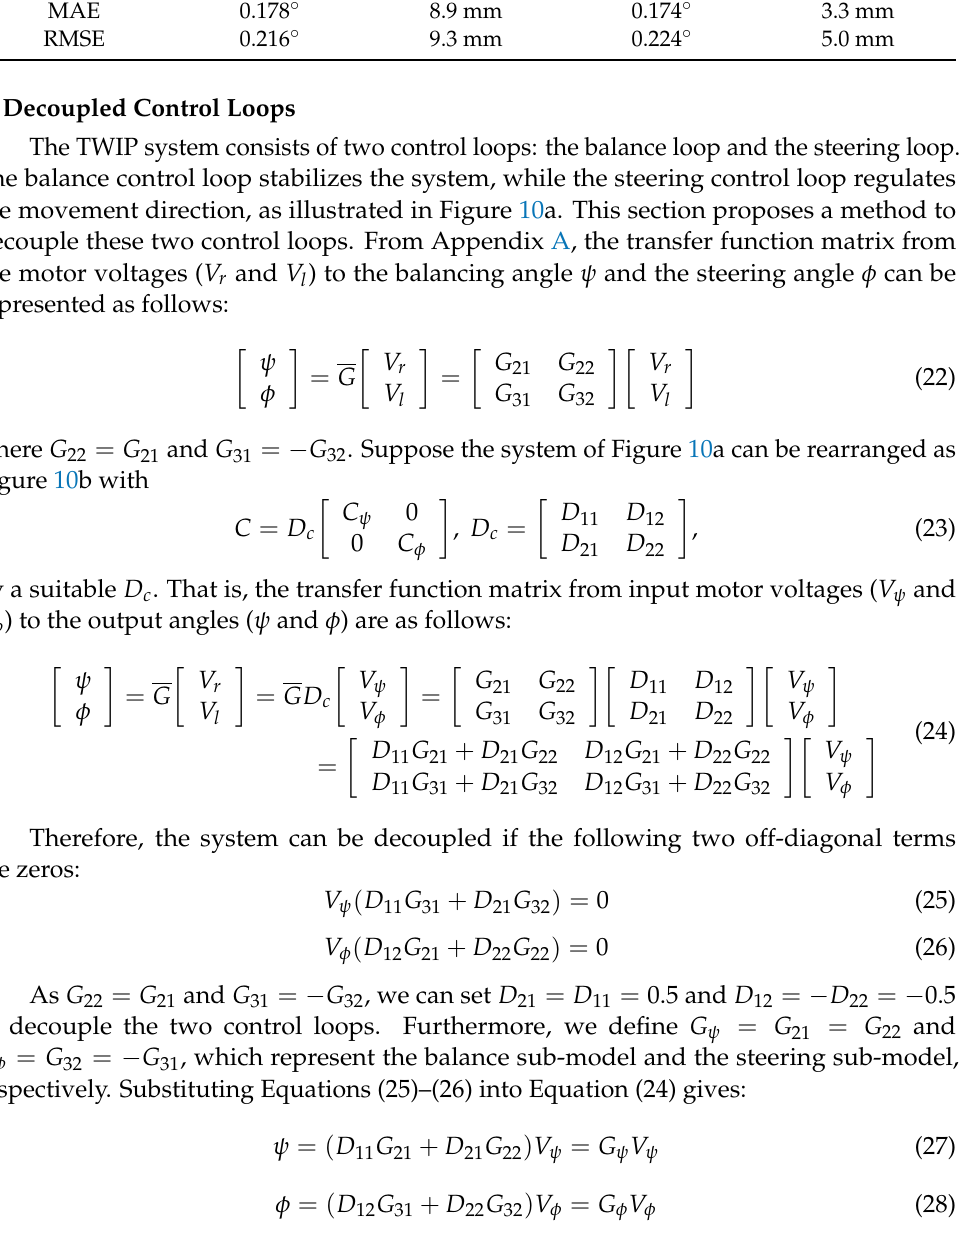
Table 2. Balancing analyses using the position loop control. Location Place 1 Place 2 Response ψ P ψ P Rise time 0.40 s — 0.40 s — Settling time 2.84 s — 4.91 s — Overshoot 0.97 ◦ 11 mm 1.52 ◦ 52 mm maximum MAE 0.178 ◦ 8.9 mm 0.174